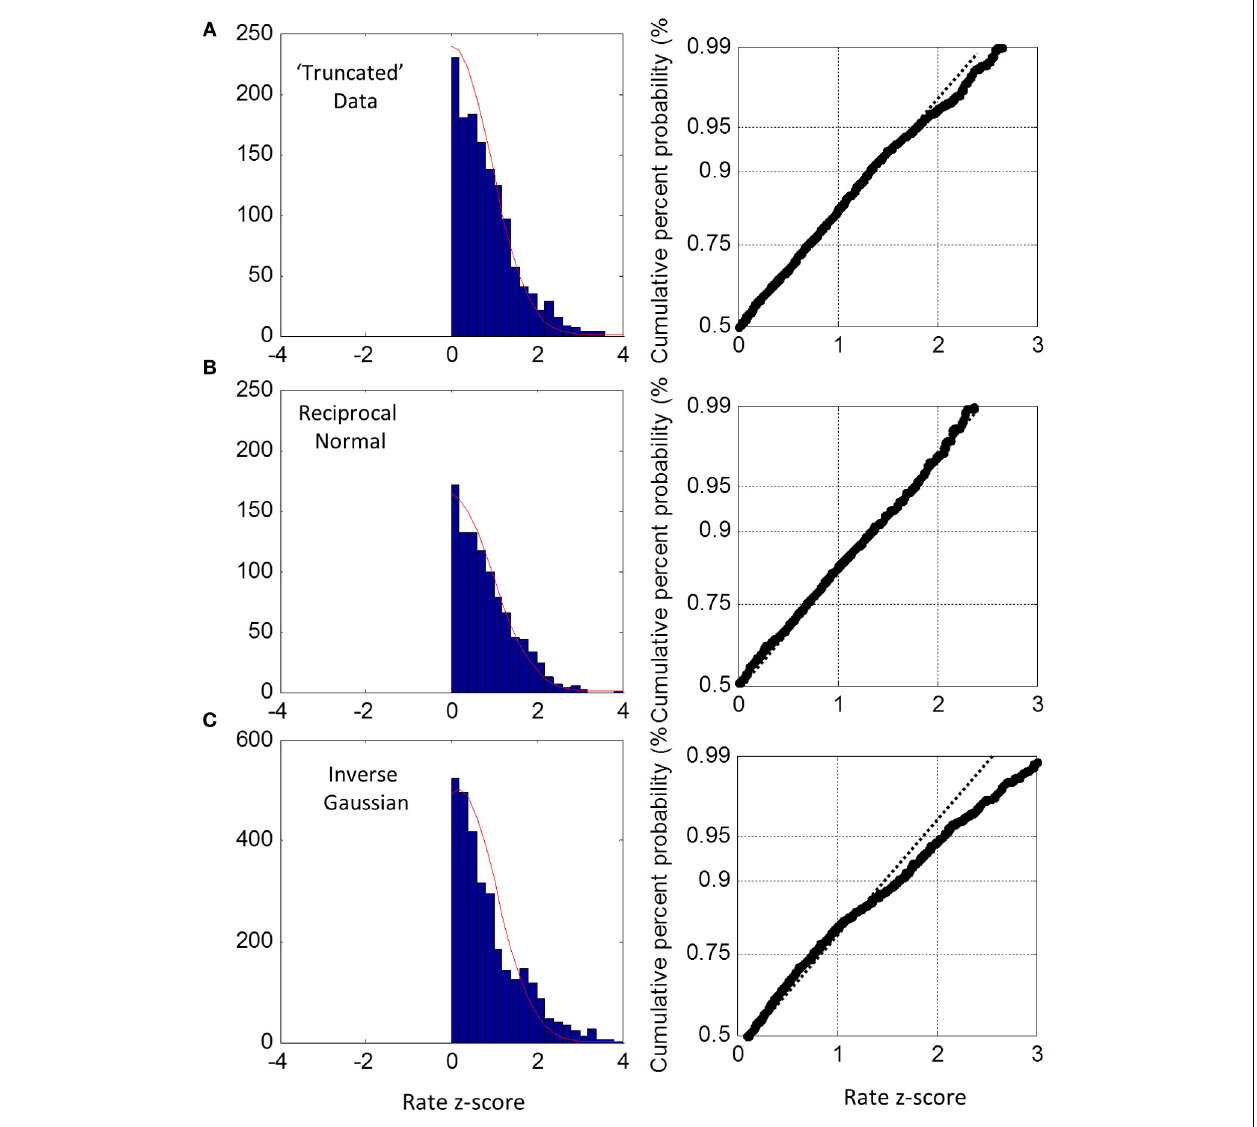
FIGURE 6 | Truncated group rate histograms (left column) and rate probit plots (right column), shown only for positive z-scores (see text). (A) Empirical rate from “truncated” blocks (c.v. > 0.4) showing near Normal distribution over 50–95%